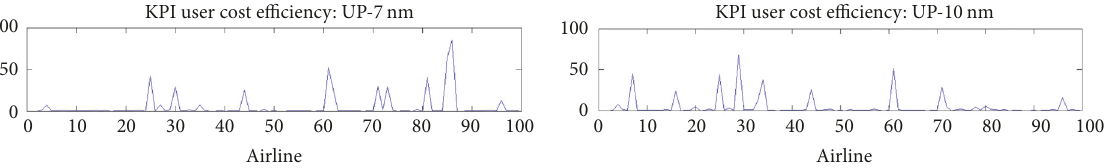
Figure 11: User cost efficiency (Kg/flight) in analysis cases 7NM/100-AUs/CI = 0 versus 10NM/100-AUs/CI = 0. KPI user cost efficiency: UP- 7ＨＧ 100